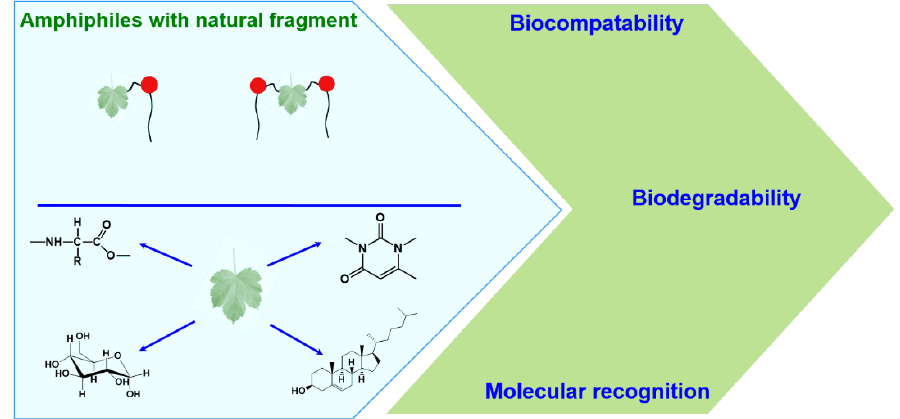
Figure 2. Schematic illustration of selected amphiphilic compounds bearing natural fragments and their benefits.